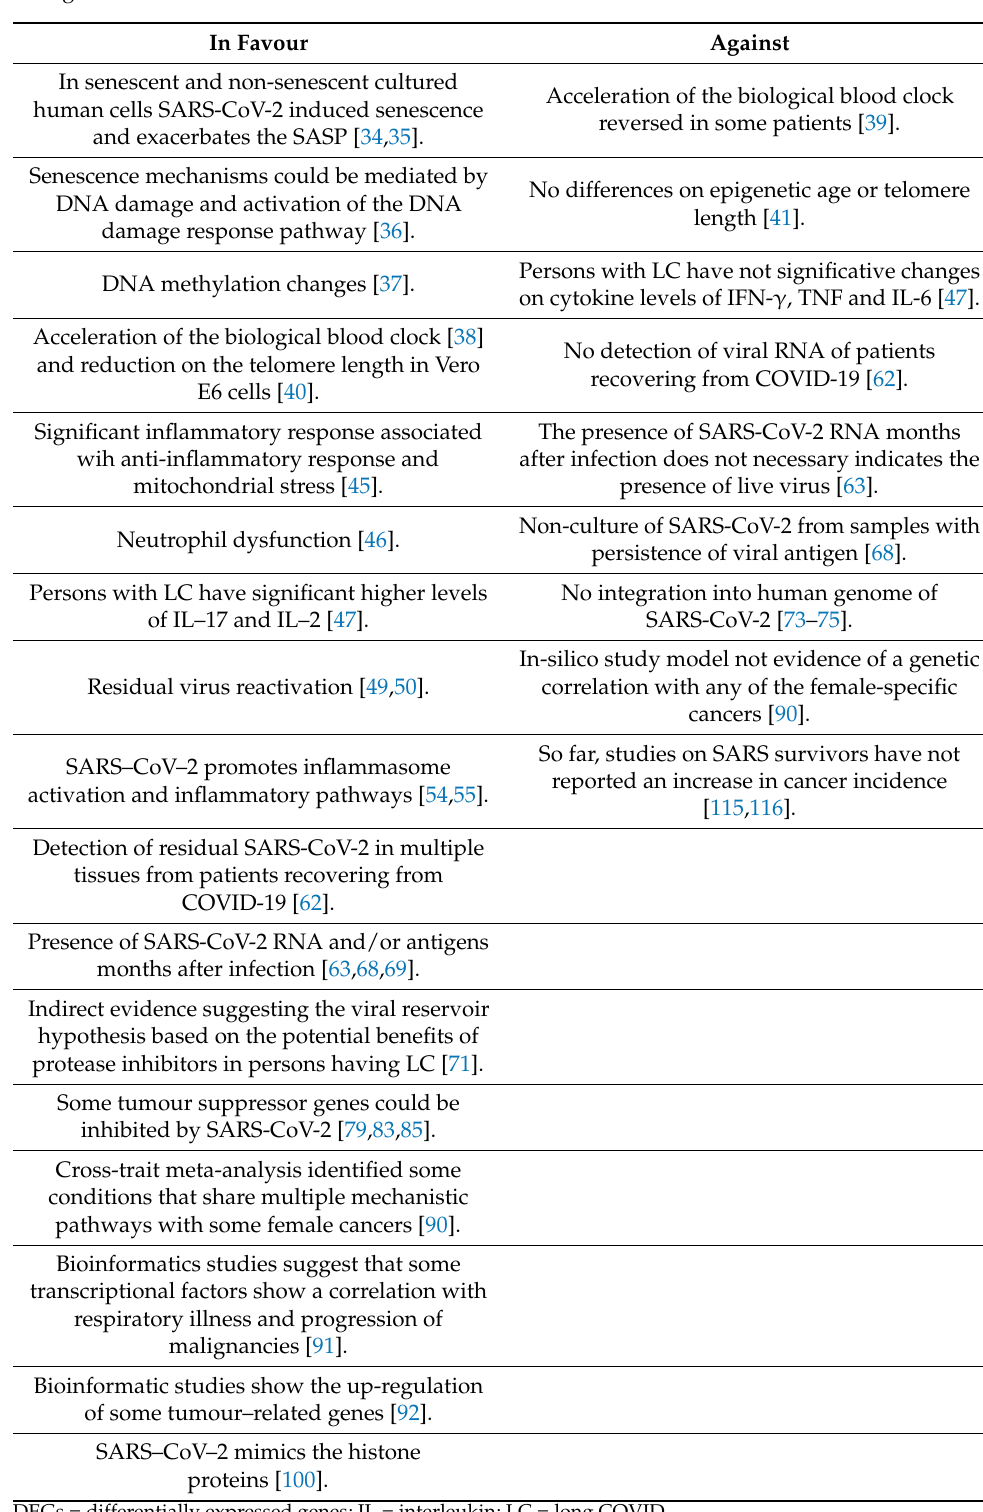
Table 1. Arguments that support or argue against the potential implication SARS–CoV–2 in